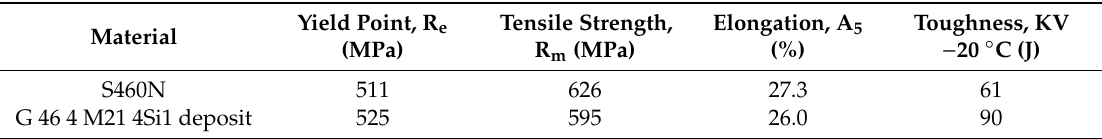
Table 2. Mechanical properties of the used materials following the manufacturer’s data (certificate 3.1 accordances with EN